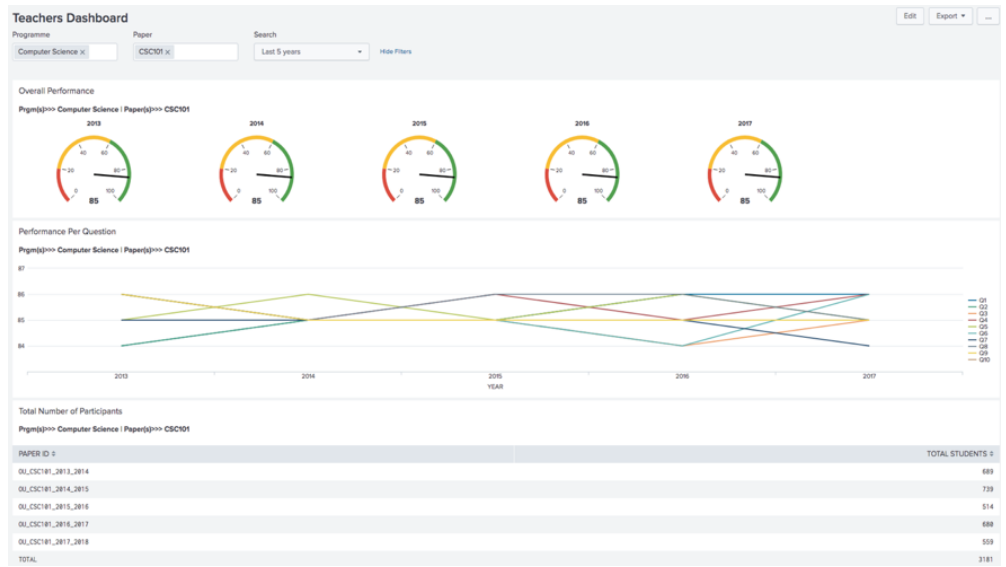
Figure 8. Performance of computer science students that participated in CS101 per year over five years.